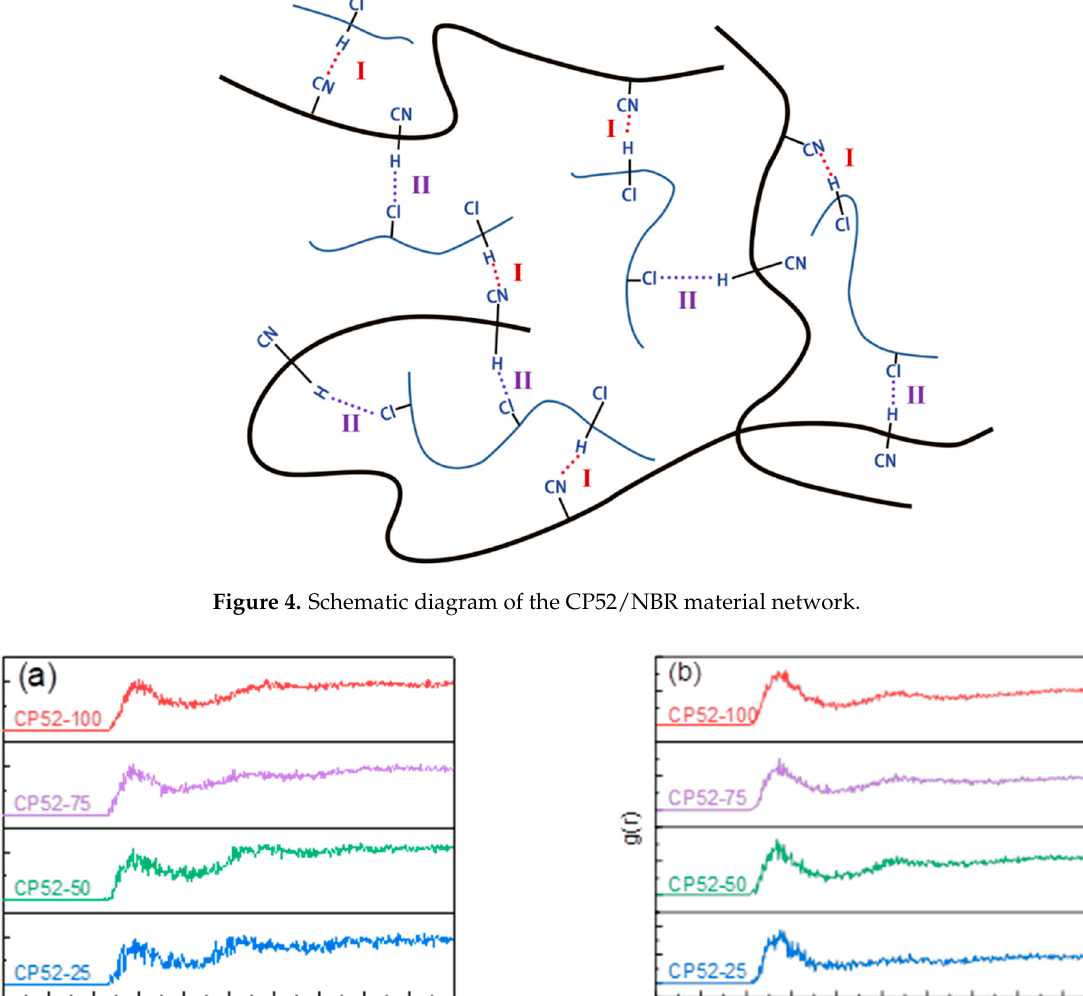
Figure 4. Schematic diagram of the CP52/NBR material network.